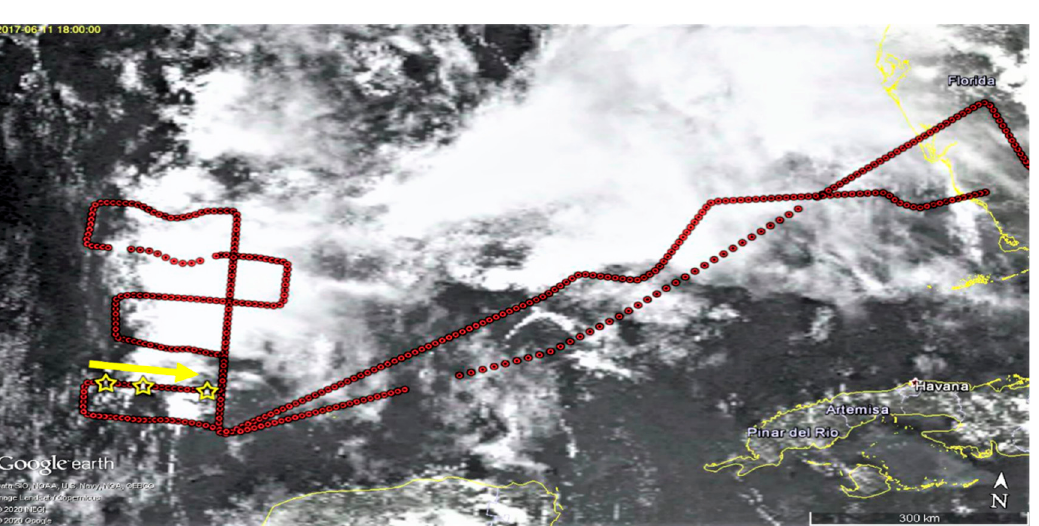
( c ) Figure 25. DAWN vertical profiles of SNR ( a ), wind speed ( b ) and wind direction ( c ) in inflow region of convection at 182534Z on 11 June 2017.